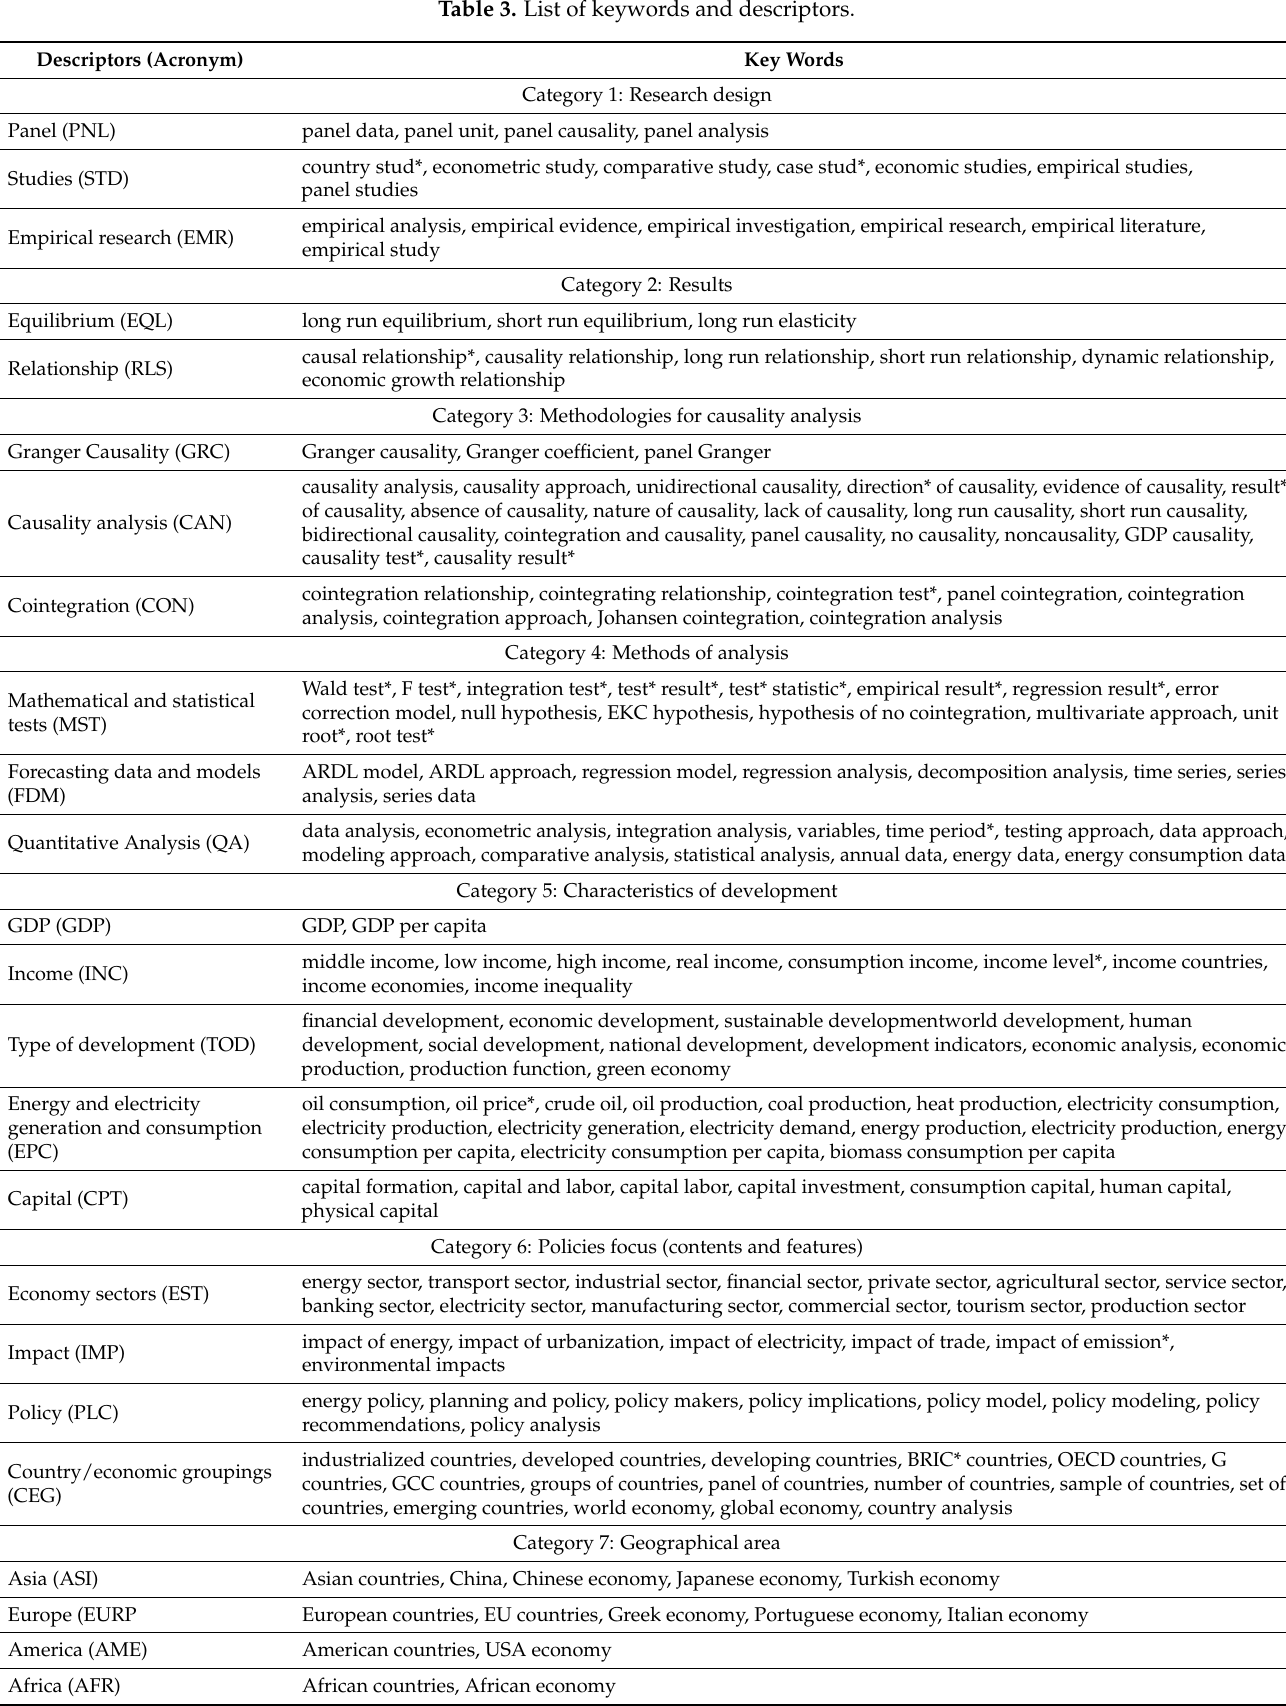
Table 3. List of keywords and